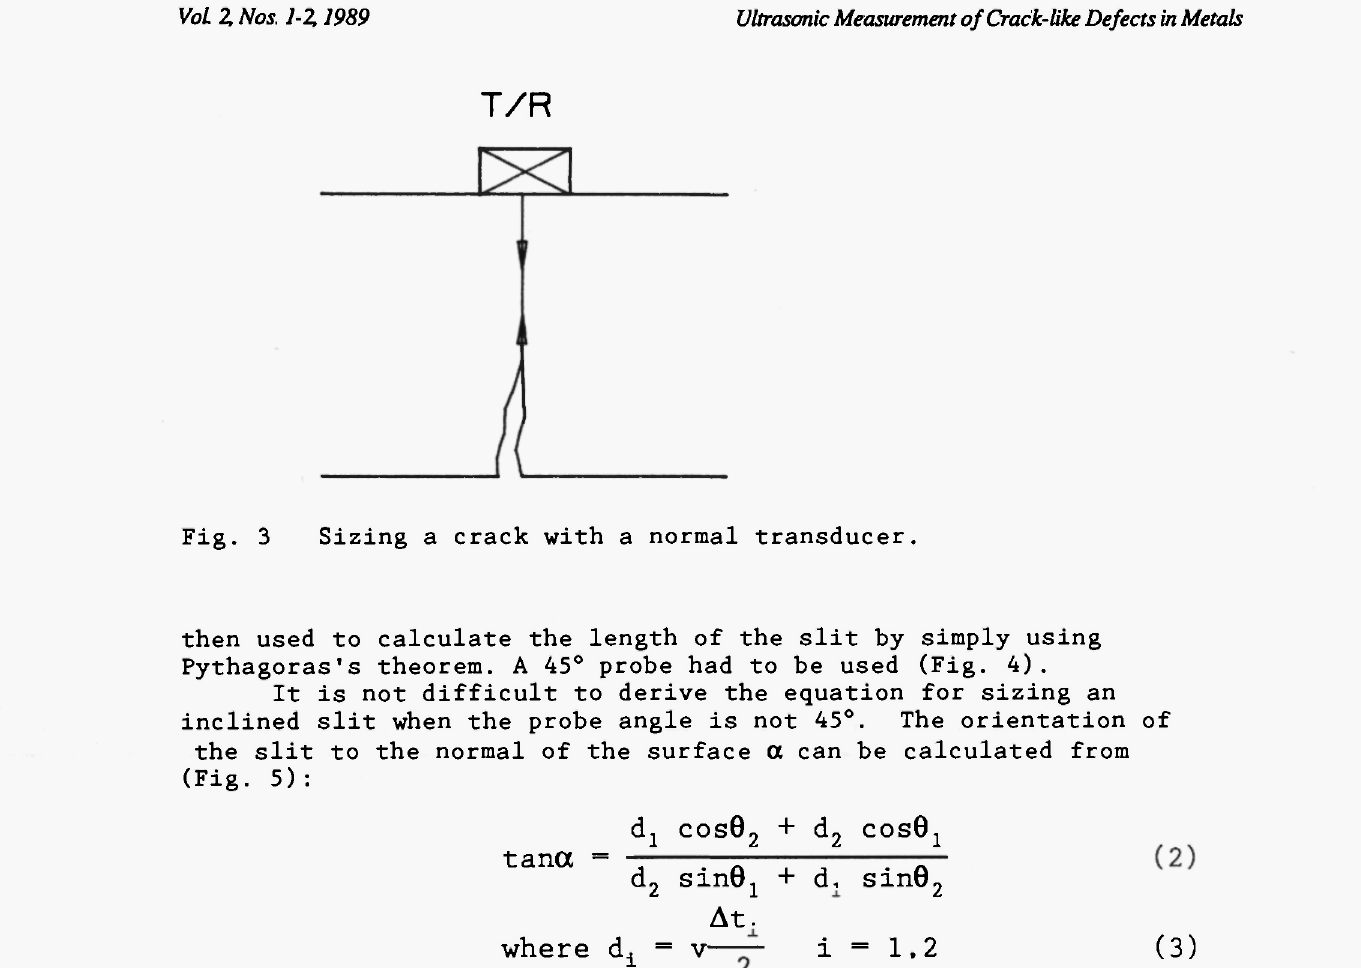
Fig. 3 Sizing a crack with a normal transducer.